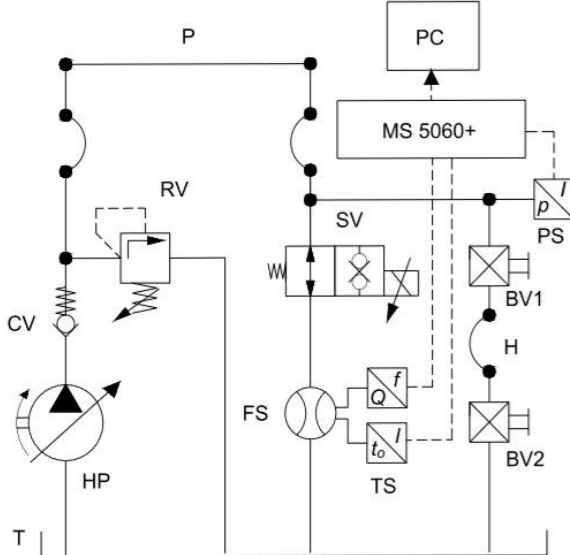
Fig. 1. Scheme of hydraulic circuit